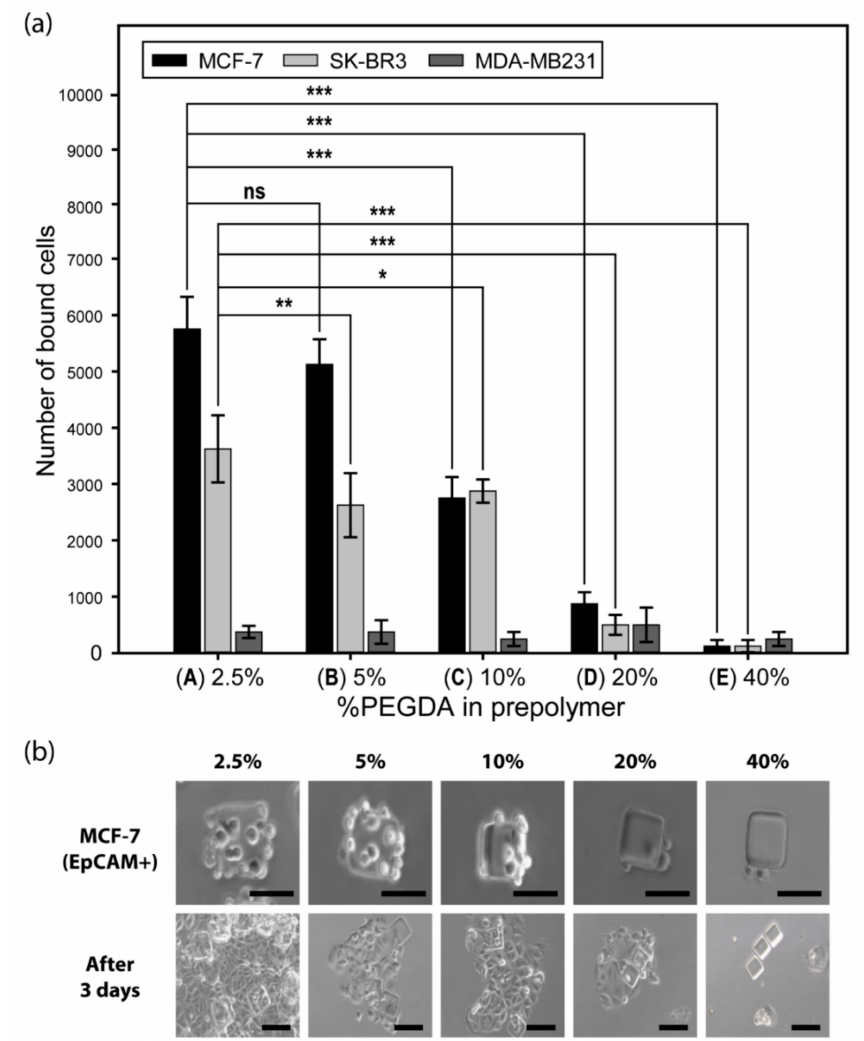
Figure 5. Cell capture by di ff erent prepolymer composition: ( a ) EpCAM expressing cells (MCF-7, SK-BR3) are captured by anti-EpCAM conjugated particles, while non-EpCAM expressing cells